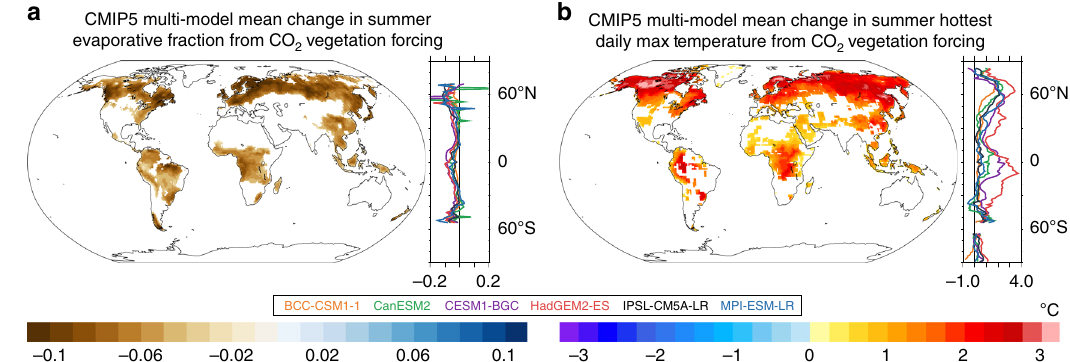
Fig. 3 Change in the evaporative fraction and surface temperature from CO 2 vegetation forcing. Multi-model mean change in summer a mean evaporative fraction (EF) (ratio of latent heat fl uxes to the sum of sensible and latent heat fl uxes), and b mean hottest daily maximum 2-meter temperature from CO 2 vegetation forcing. Only statistically signi fi cant changes are plotted (Methods). Zonal averages of EF change and hottest daily maximum temperature change (land grid points) for each model are plotted to the right of each map. Note, the magnitudes of EF change north of 65°N and over Antarctica are very large in some models, and are masked out in the zonal average plot. June – September (December – March) values are used in the Northern (Southern) Hemisphere. Plots represent 30-year